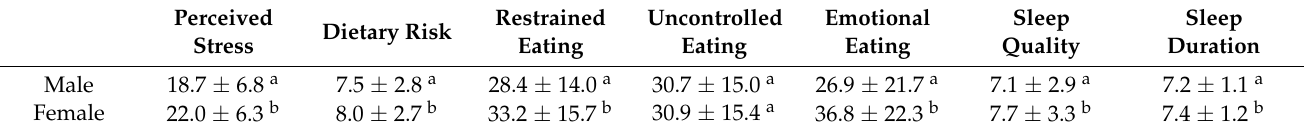
Table 4. Gender differences in outcomes of